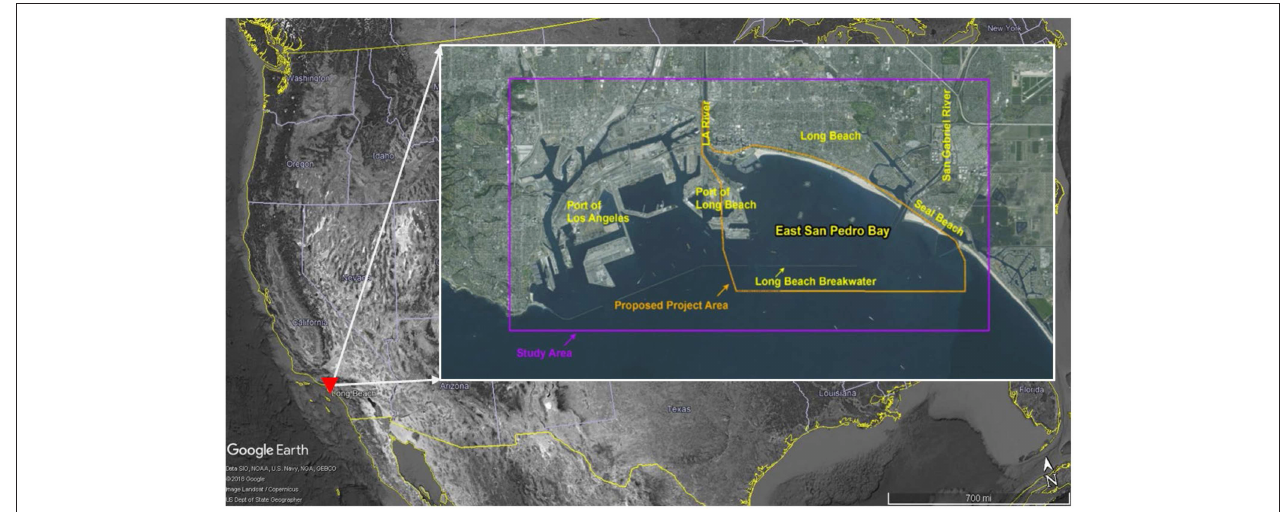
FIGURE 2 | Map of East San Pedro Bay study